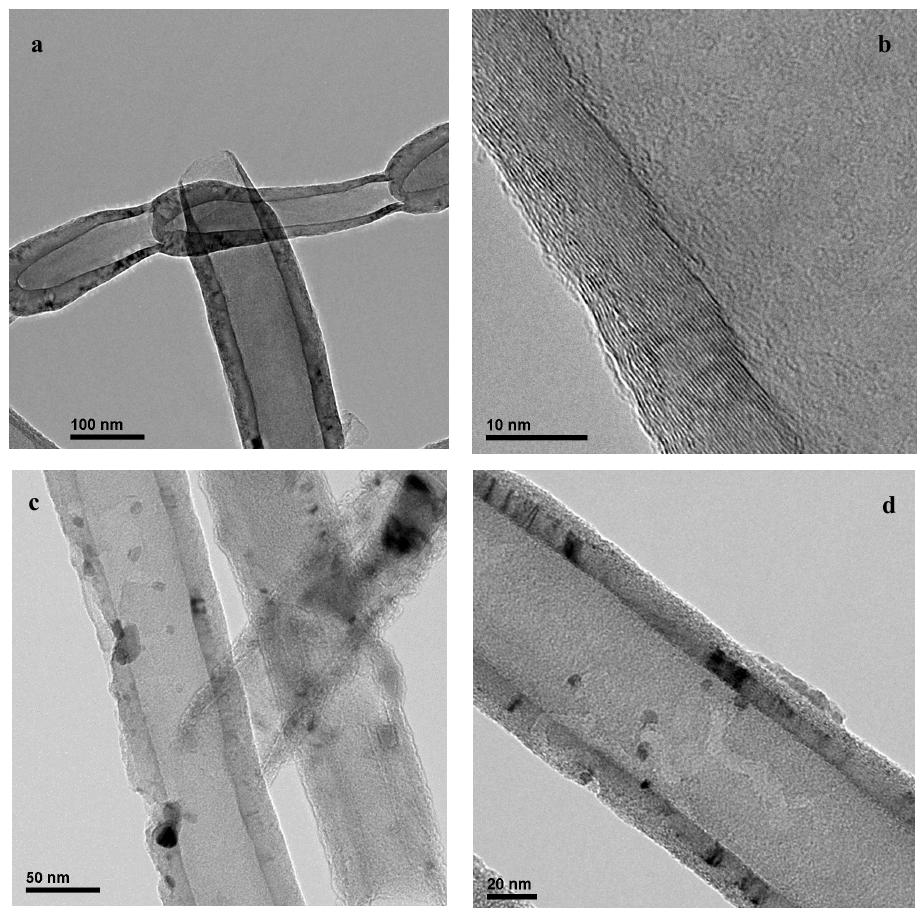
Figure 2. Transmission Electron Microscopy (TEM) micrographs of the CNF o ( a , b ) and β-Mo 2 C/CNF catalyst ( c , d ).